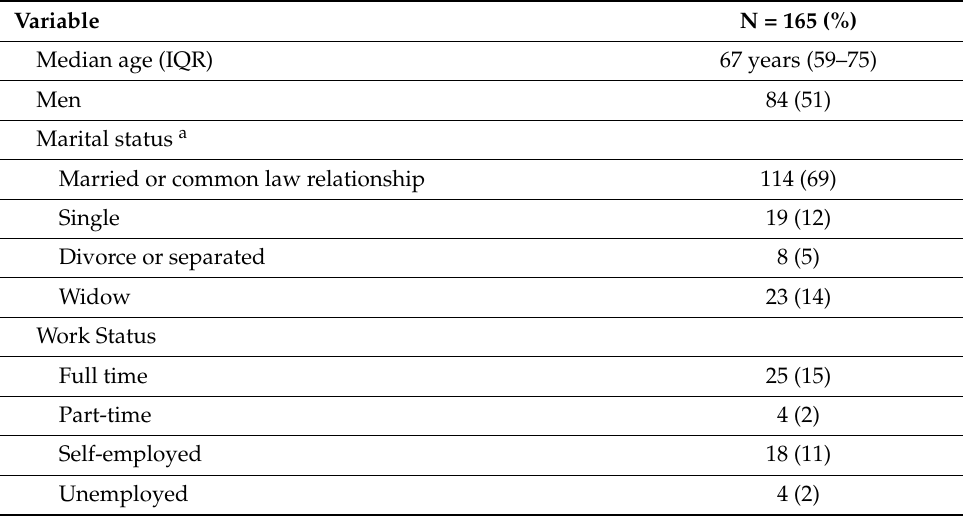
Table 1. Sociodemographic characteristics of